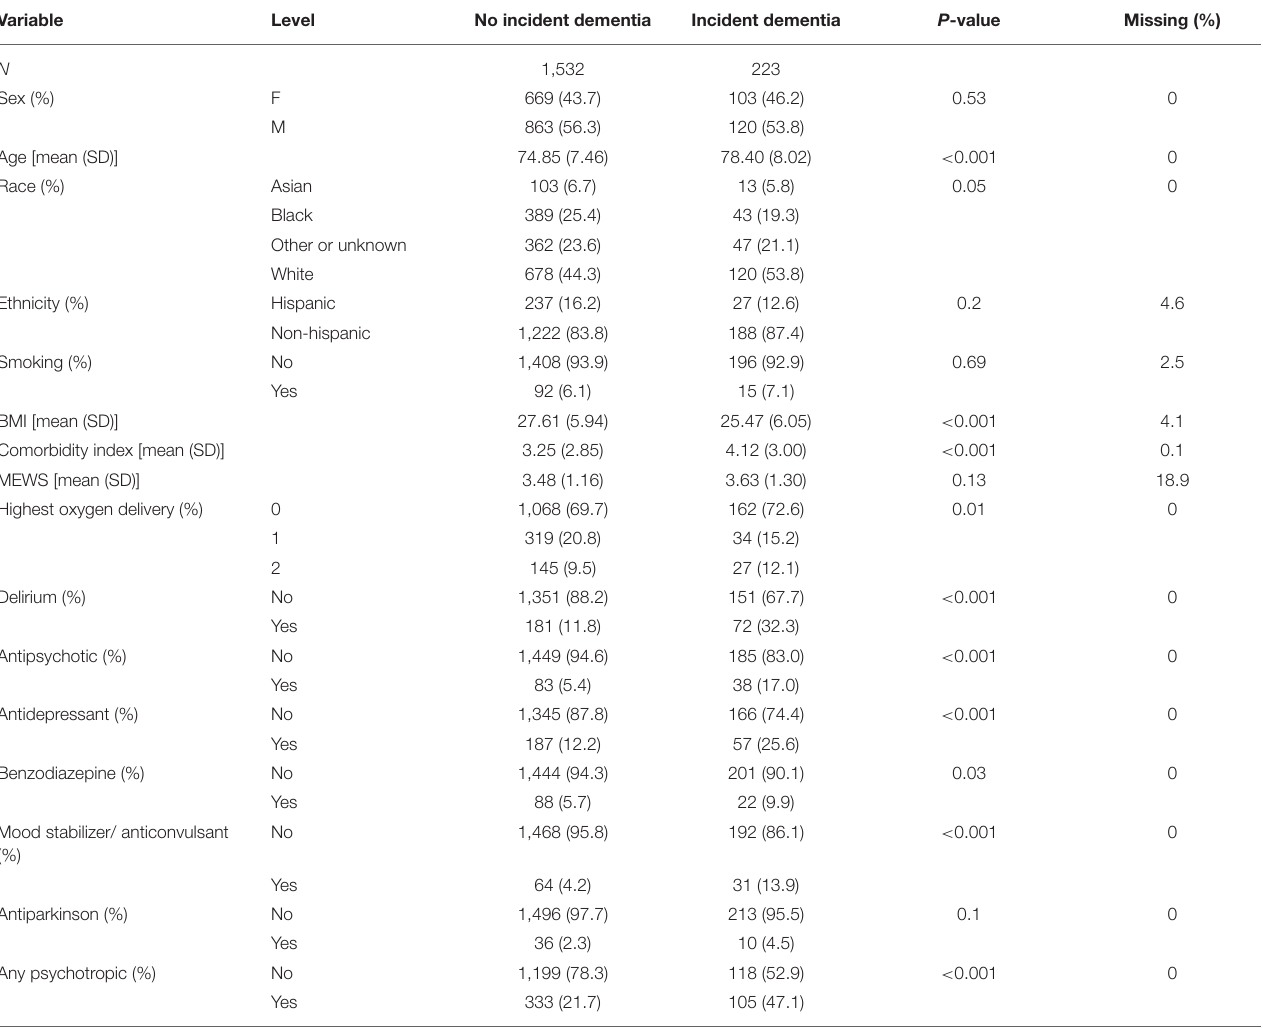
TABLE 1 | Patient demographics and characteristics stratified by post-COVID incident dementia (unadjusted). Variable Level No incident